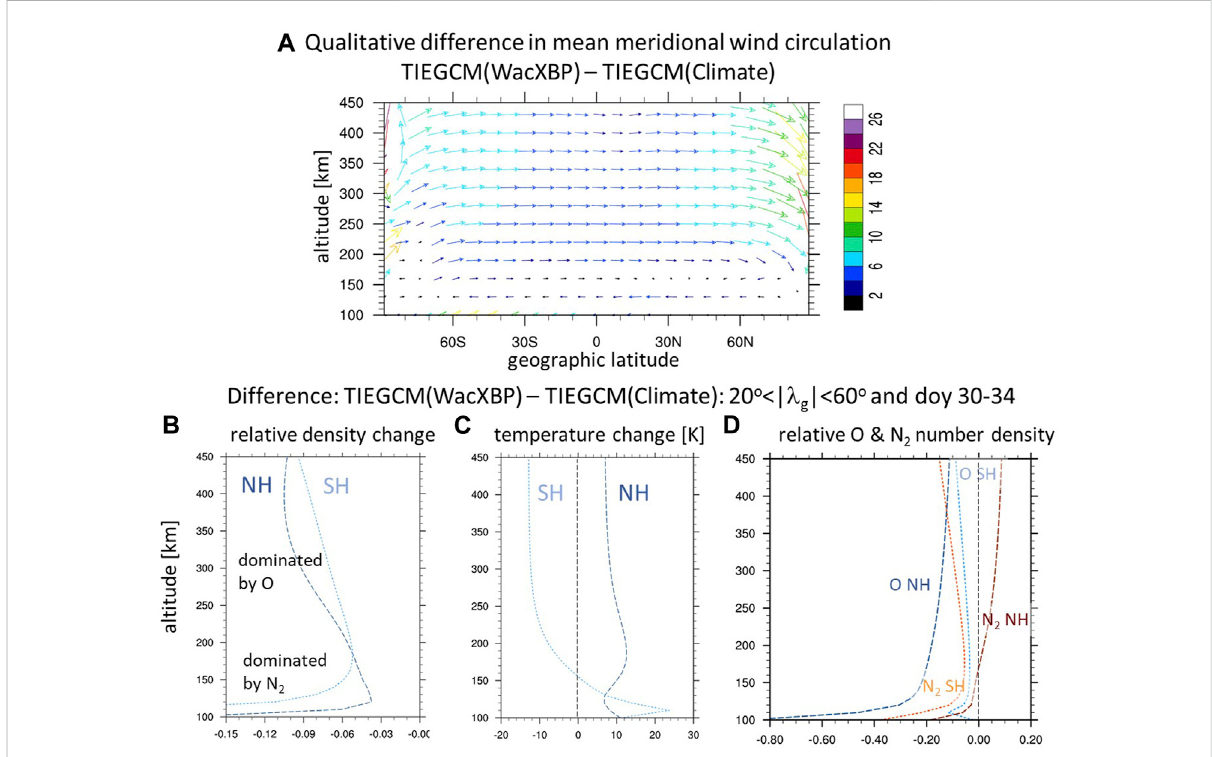
FIGURE 7 (A) . Difference between TIEGCM(WacXBP) and TIEGCM(Climate) of doy 30 – 34 in (A) . the diurnal and zonal mean circulation (qualitative, the vertical velocity is increased by a factor of 30 for better illustration); (B – D) . average changes over 20 o < | λ g | ≤ 60 o and doy 30 – 34 between TIEGCM(WacXBP) and TIEGCM(Climate) with altitude of (B) . neutral density with respect to TIEGCM(WacXBP); (C) . temperature [K], (D) . O and N 2 number density with respect to